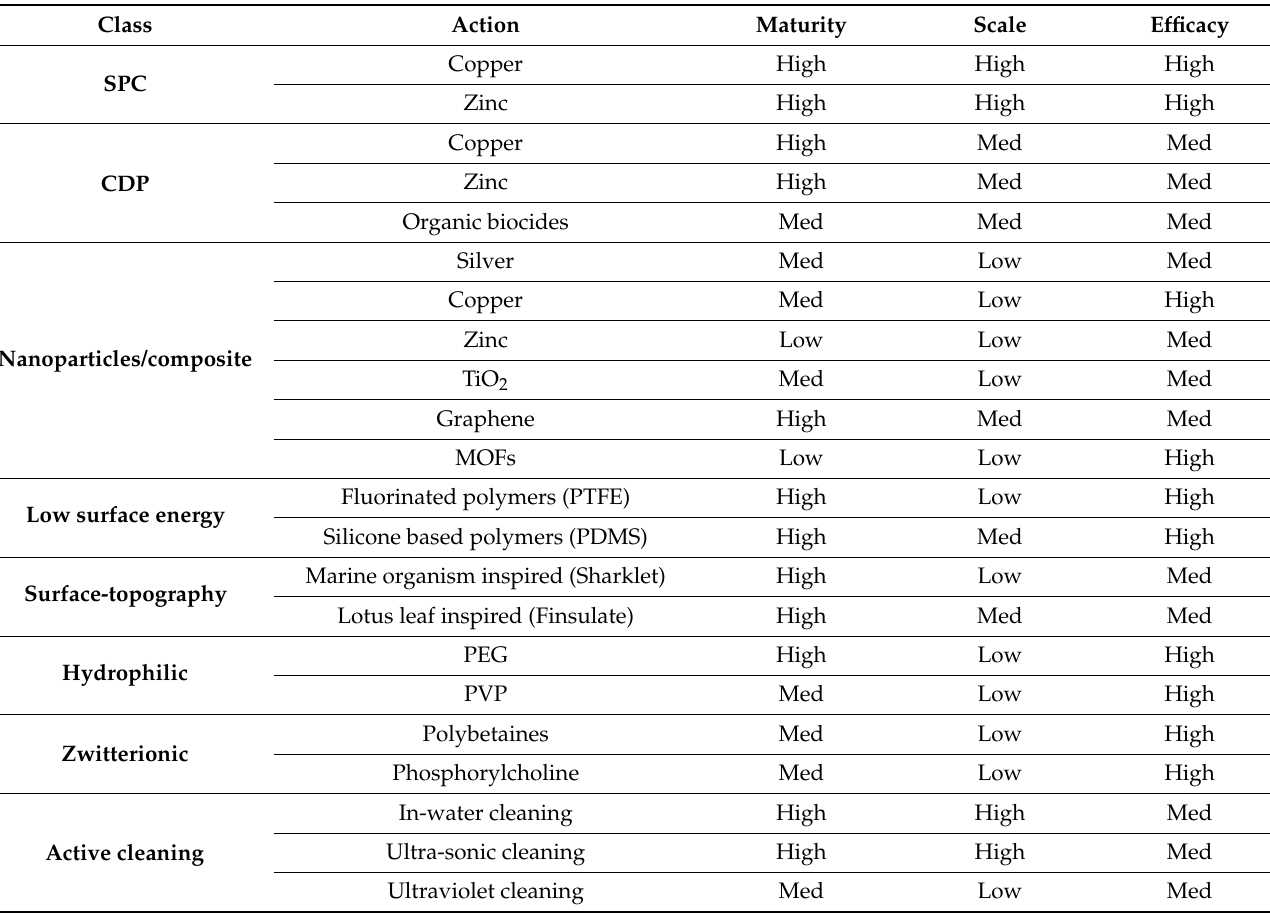
Table 3. Summary of various antifouling strategies with different materials in the